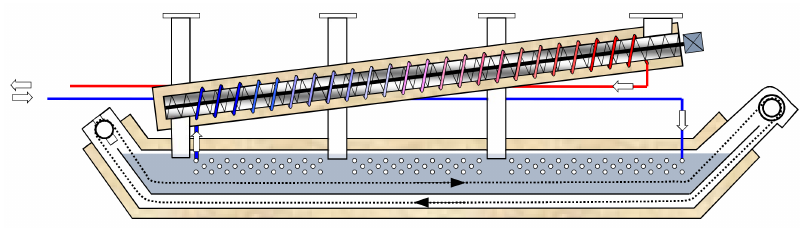
Figure 15. A direct slag waste heat recovery extended by crushing and homogenizing of the slag in a worm conveyor tube covered by the additional heat exchanger coil.